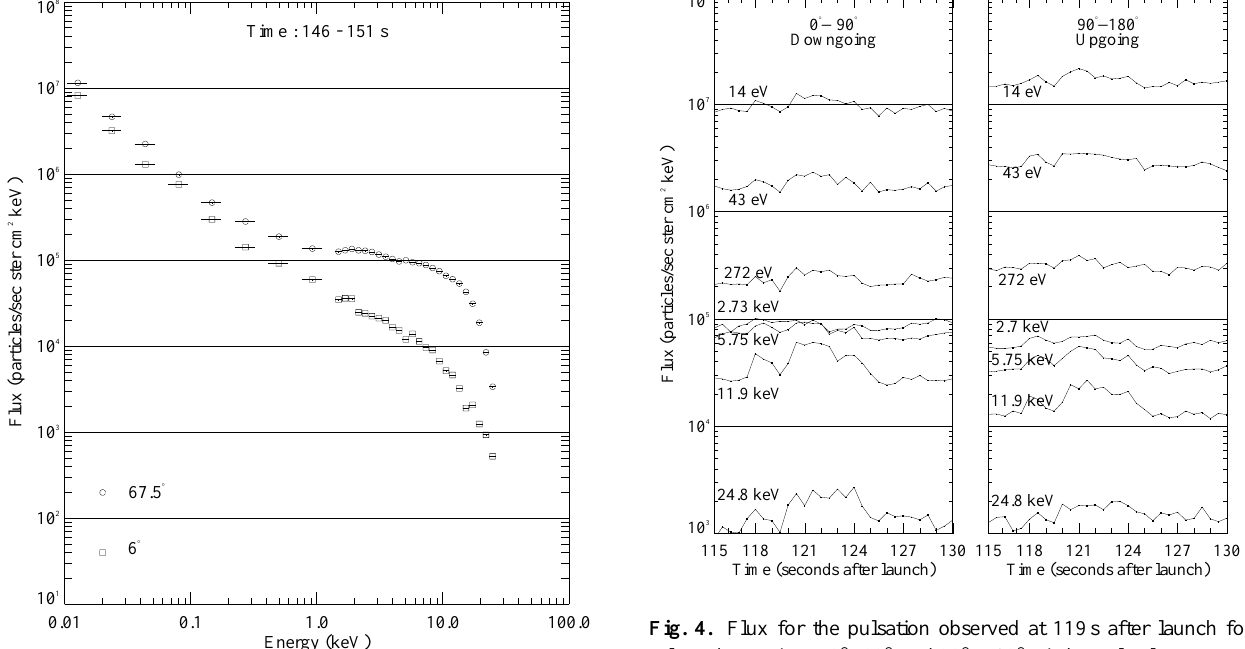
Fig. 4. Flux for the pulsation observed at 119s after launch for selected energies at 0 ◦ –90 ◦ and 90 ◦ –180 ◦ pitch-angle